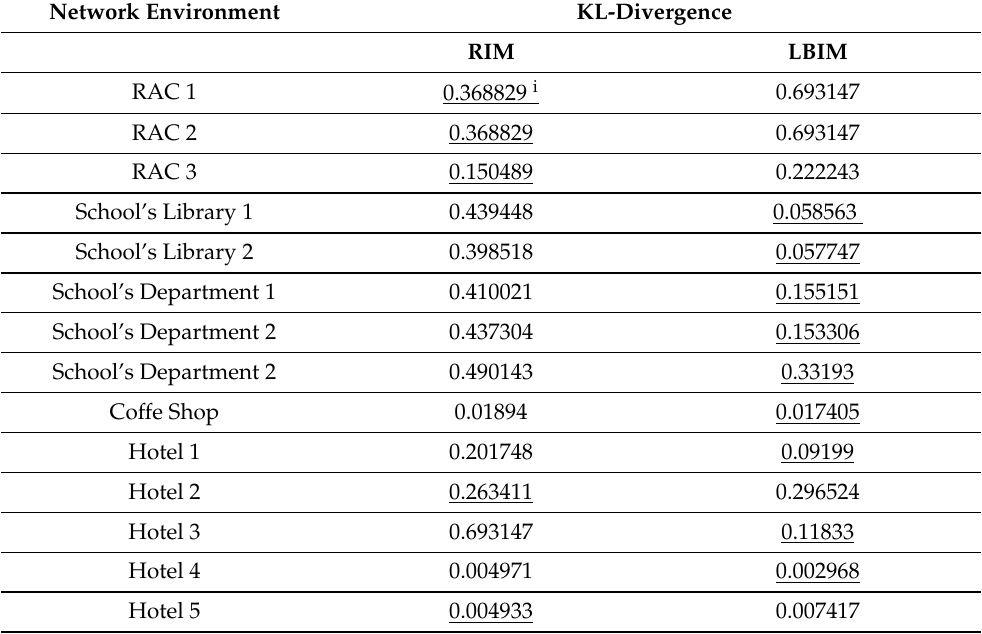
Table 1. KL-divergence of the RIM and the LBIM for different network environments. Network